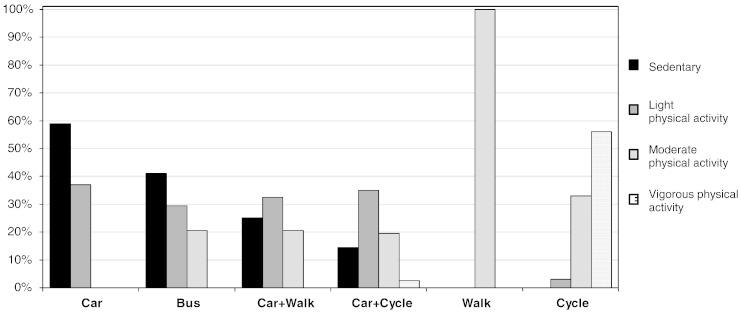
Median percentage of journey duration spent sedentary and in light, moderate, and vigorous physical activity.Note: This figure presents the median percentage of journey duration spent sedentary and in different intensities of physical activity because the data were highly skewed. As a result, the values of the columns within each journey type may not sum to 100%. Time spent in activity was classified as sedentary behaviour (< 1.5 MET), light (1.5–3 MET), moderate (3–6 MET), and vigorous (> 6 MET) intensity physical activity. Data were collected in 2010 and 2011 in Cambridge.Compared to those who drove all the way to or from work, participants using any other mode or combination of modes of transport recorded journeys of higher metabolic cost (Table 2; all p ≤ 0.04). For example, those using the bus expended an additional 0.7 MET on average, and those who walked or cycled all the way expended nearly an additional 2.5 and 3.9 MET respectively, than those who drove all the way.